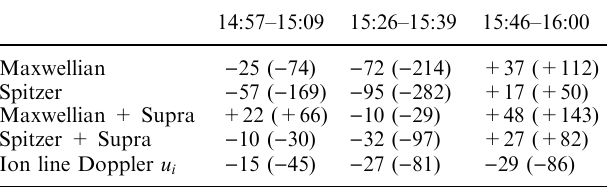
Fig. 11. The upper panel shows the estimated ion drift velocity u i ( thick line ) from the ion line analysis and the electron drift velocity u e ( thin line ) from the analysis method based on Eq. (8) with a suprathermal population described by the distribution function of Fig.8withaMaxwellianbackgroundofparametersofFig.6.The lower panel shows the estimated plasma frequency x e = 2 p given by Eq. (9)